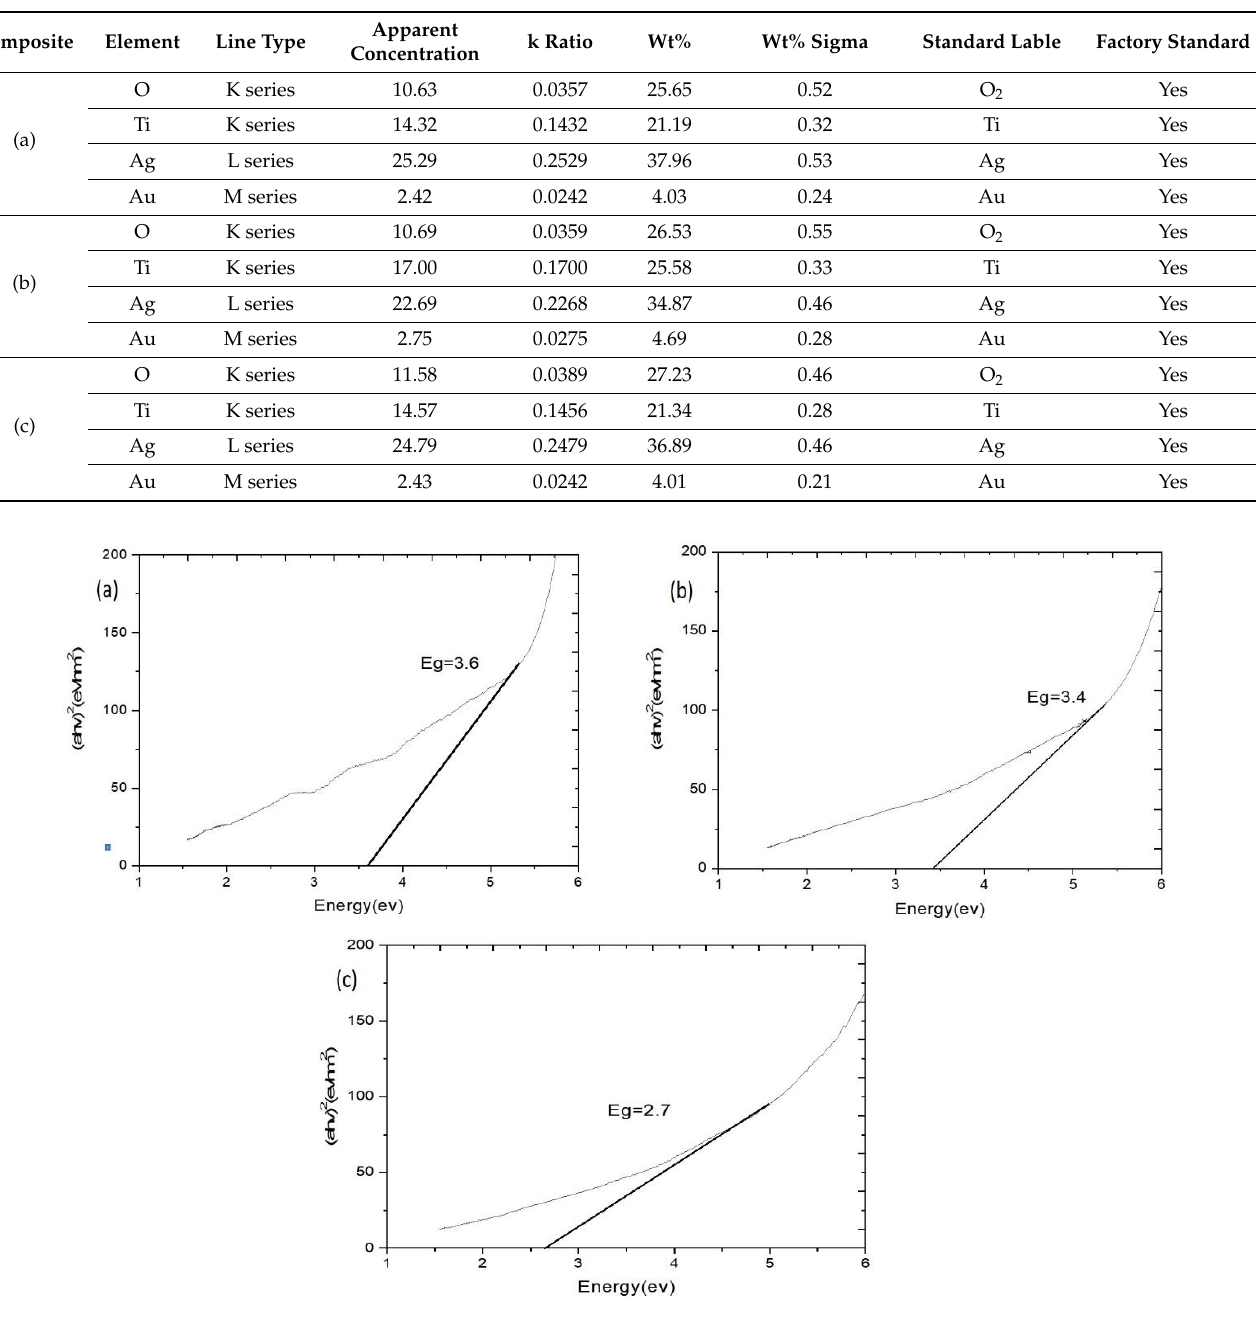
Figure 6. ( a ) Band gap of 0.5 Ag/TiO 2 composite. ( b ) Band gap of 0.1 Ag/TiO 2 composite. ( c ) Band gap of 0.01 Ag/TiO 2 composite.